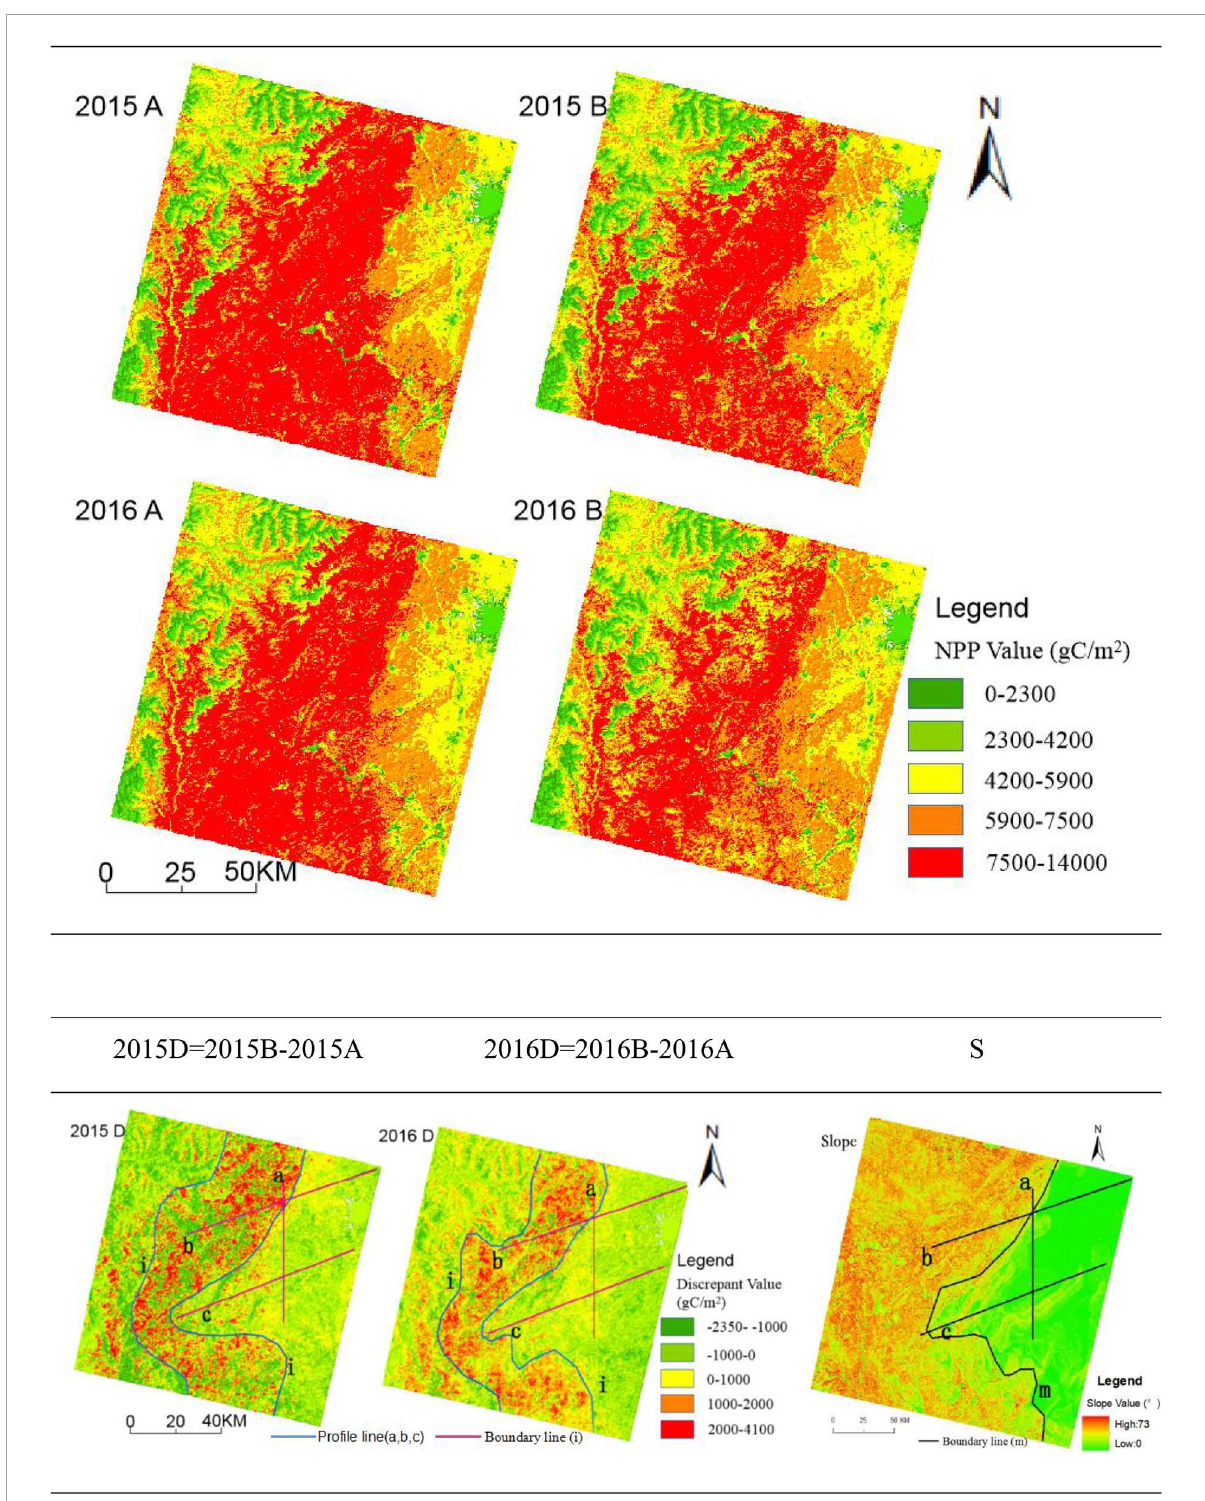
FIGURE4 Discrepant data and profile line distribution of the improved CASA model and CASA model estimation